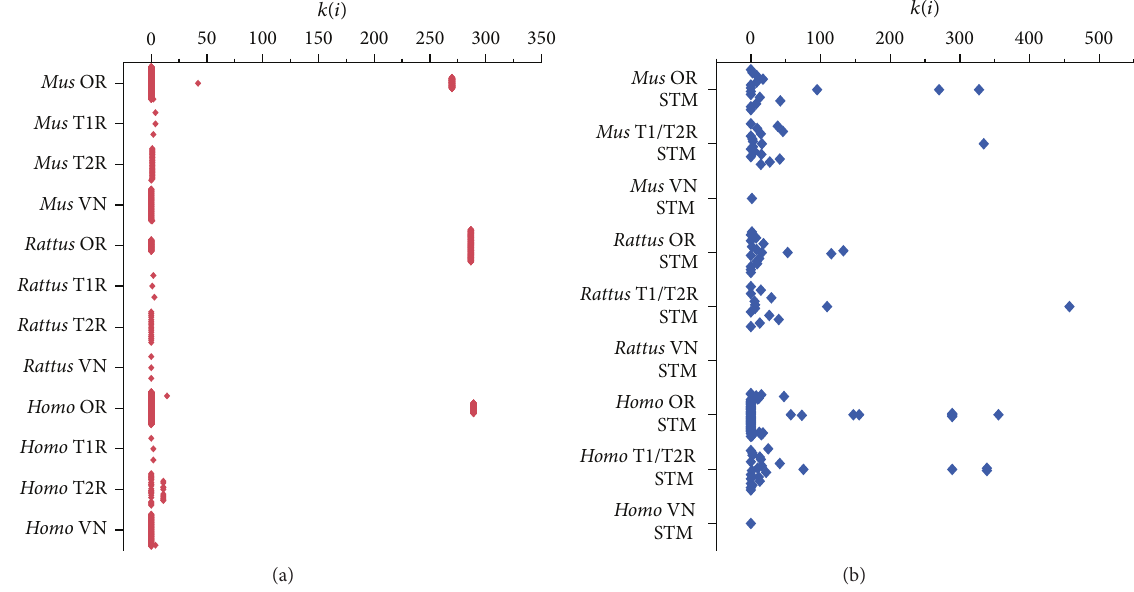
Figure 3: Connectivity values distribution for the chemoreceptors families (red) and their respective signal transducing machineries (blue). Values are shown in the vertical axis and the different subgroups are listed in the horizontal axis.